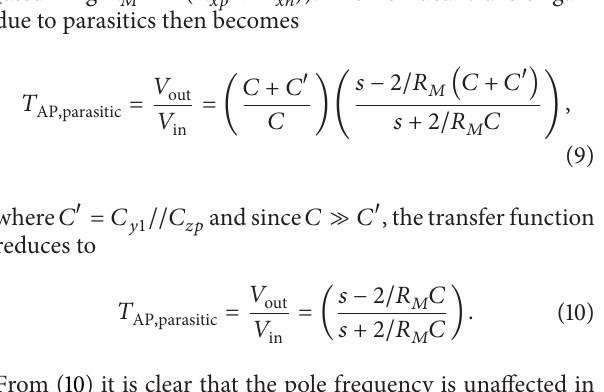
Figure 5: Frequency response showing gain and phase of APS of Figure